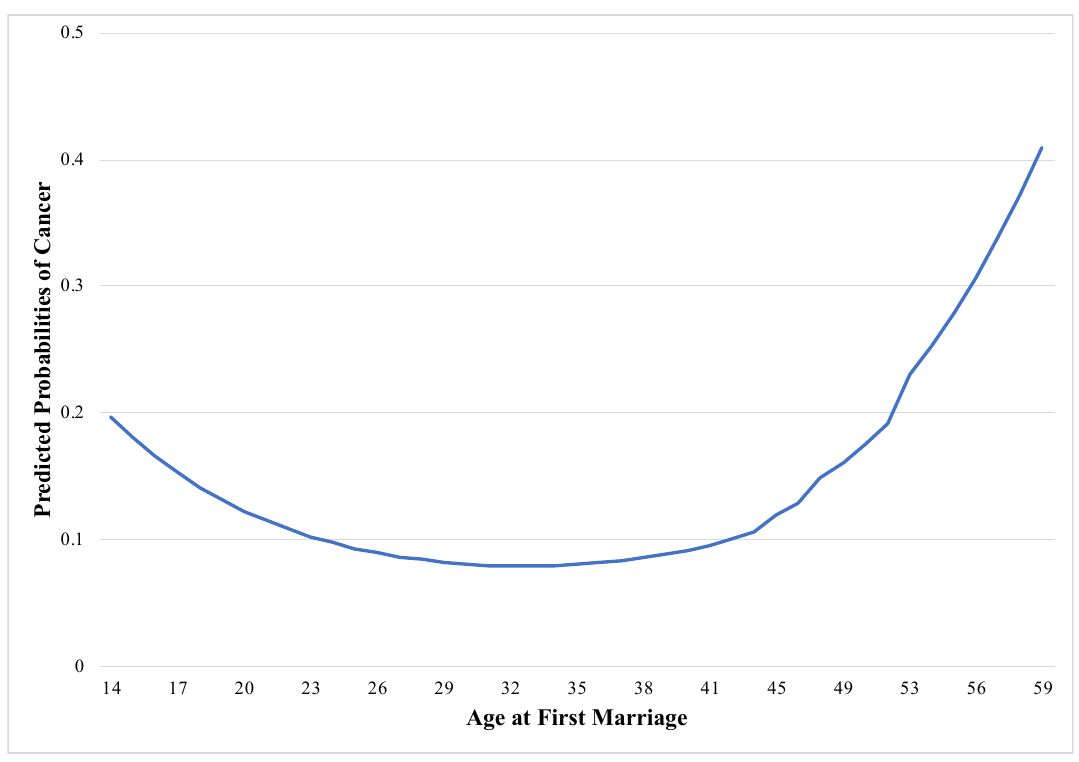
Figure 1. Cancer and age at first marriage for men.